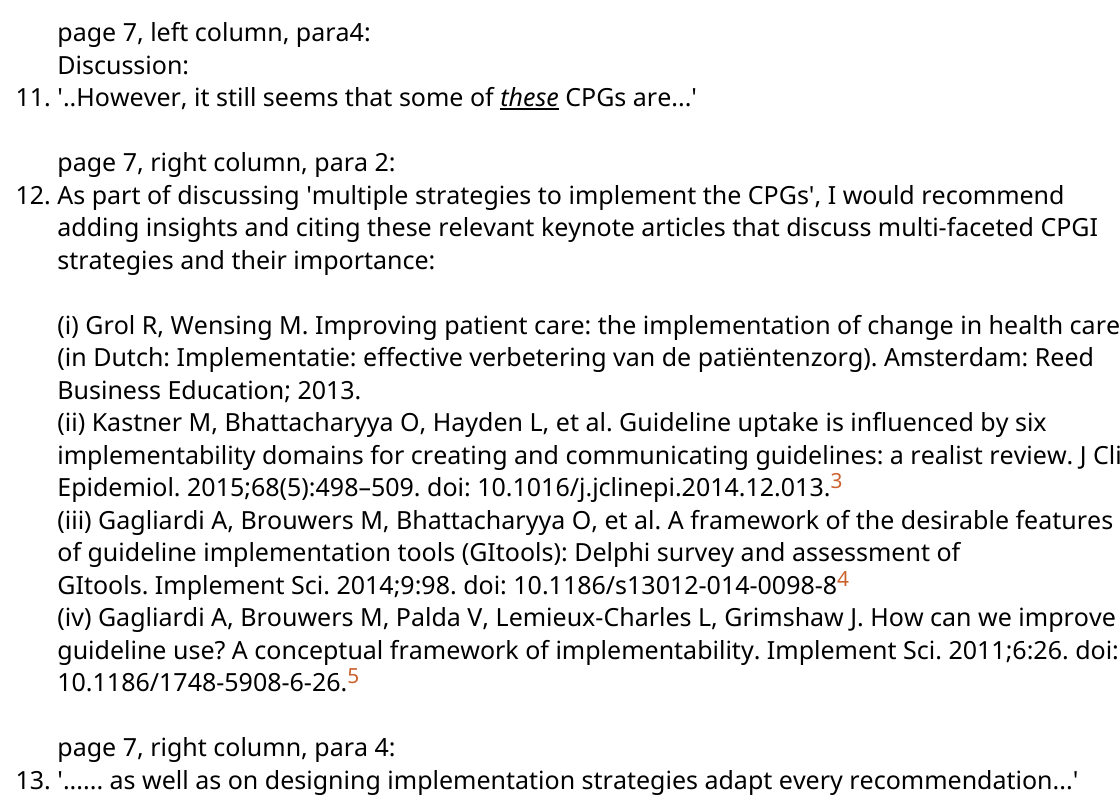
Table 1: please, if feasible, replace the question in the GRADE SoF table; '.....the results for cardiopulmonary resuscitation?' with '.....the outcomes for cardiopulmonary resuscitation?' page 7, left column